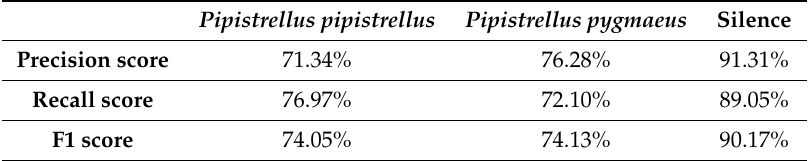
Table 2. Results of the classification model using the spectrogram energy matrices.